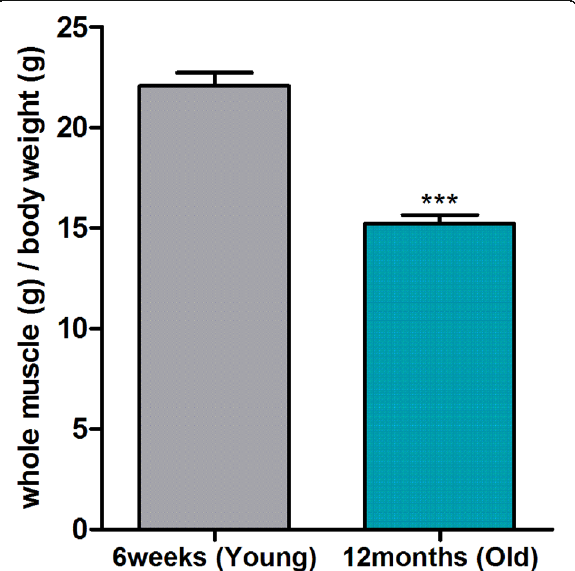
Fig. 1 Comparison of thigh and calf skeletal muscle weight between young (6 weeks) and old (12 months) rats. After stabilization for 10 days, young and old groups were sacrificed to obtain thigh and calf skeletal muscles. Muscle weights were divided by body weights. We utilized 5 animals for each group. Data are presented as means ± SEM. Statically significance was determined by Student ’ s t-test; *** p <